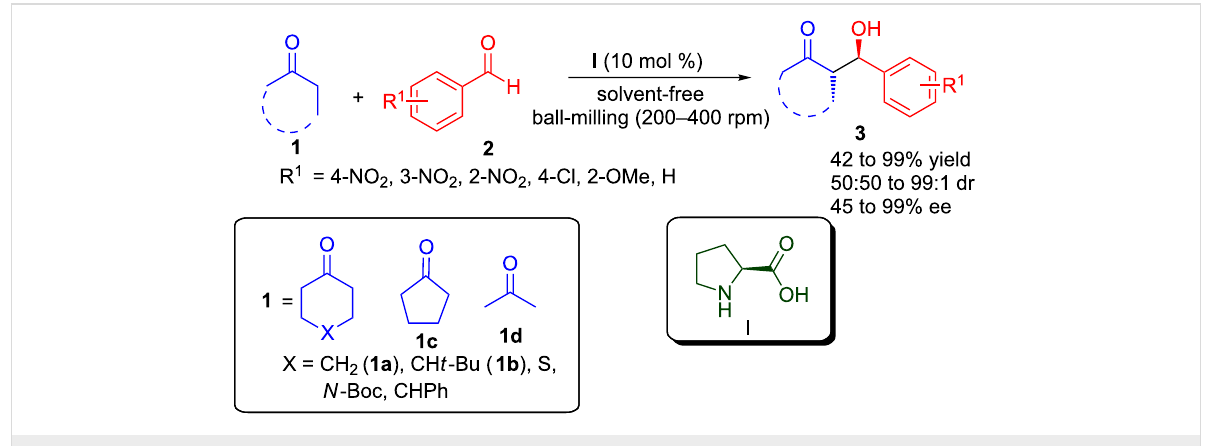
Scheme 1: Proline-catalysed aldol reaction in a